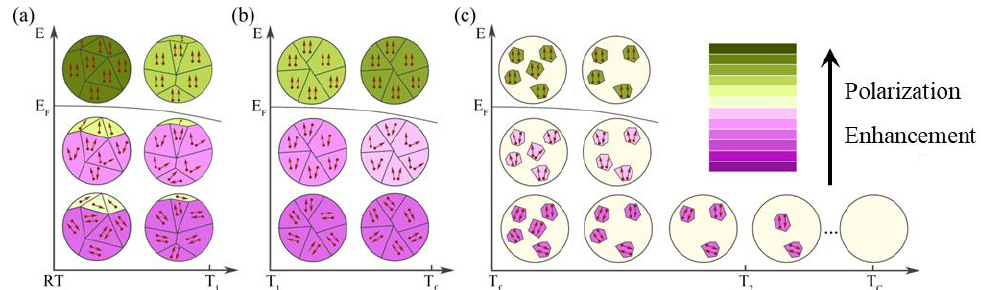
Figure 5. Schematic representation of the positive and negative ECE process of AgNbO 3 antiferroelectric ceramics upon application of an external electric field under different temperatures: ( a ) T < T 1 ; ( b ) T 1 < T < T f ; ( c ) T > T f . Purple depth indicates the strength of antiferroelectricity; green depth indicates the strength of ferroelectricity.